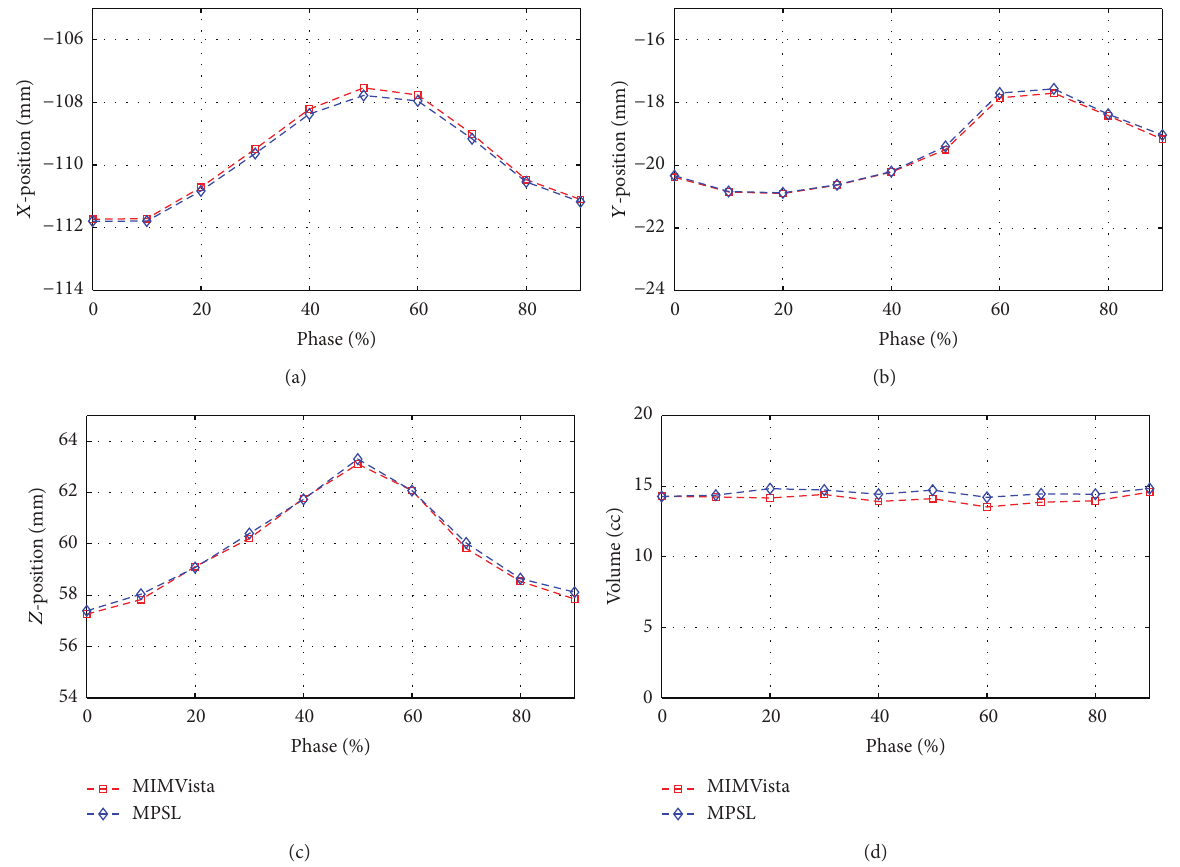
Figure 6: Good agreement of MPSL based estimation of GTV position and volume quantification with MIMVista based estimation for different phases of the 4DCT scan shown in a patient with 15cc